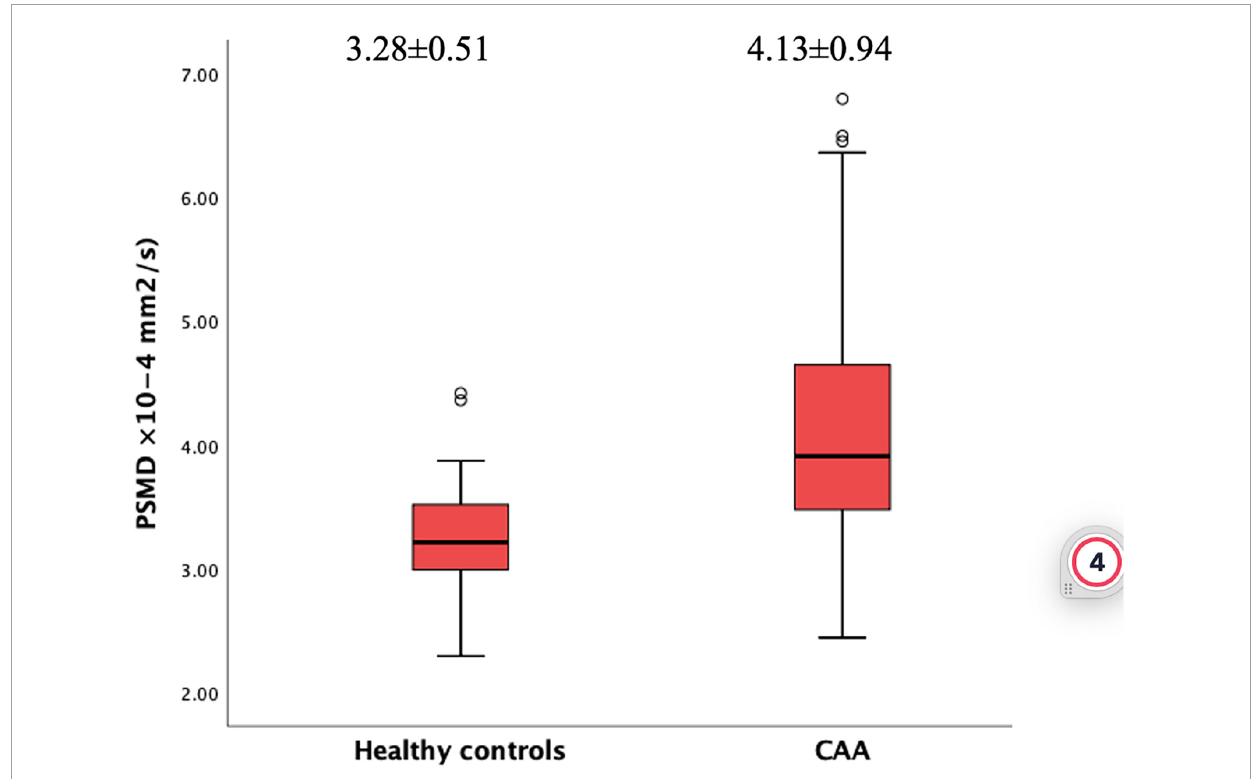
FIGURE2 Boxplot of PSMD values in patients with CAA and healthy